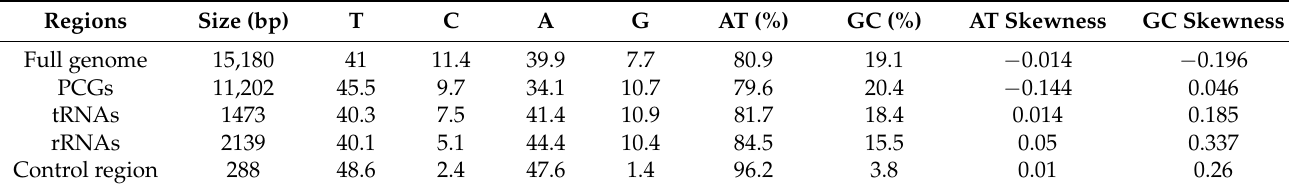
Table 3. Composition and skewness in the C. perspectalis